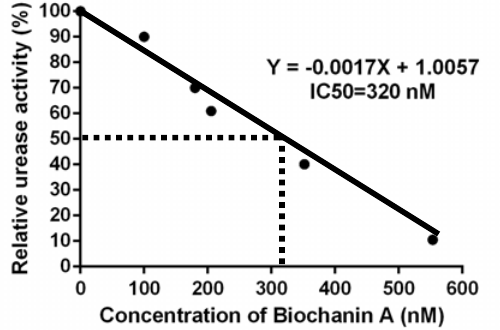
Figure 3. Biochanin A inhibits rumen bacterial urease activity.